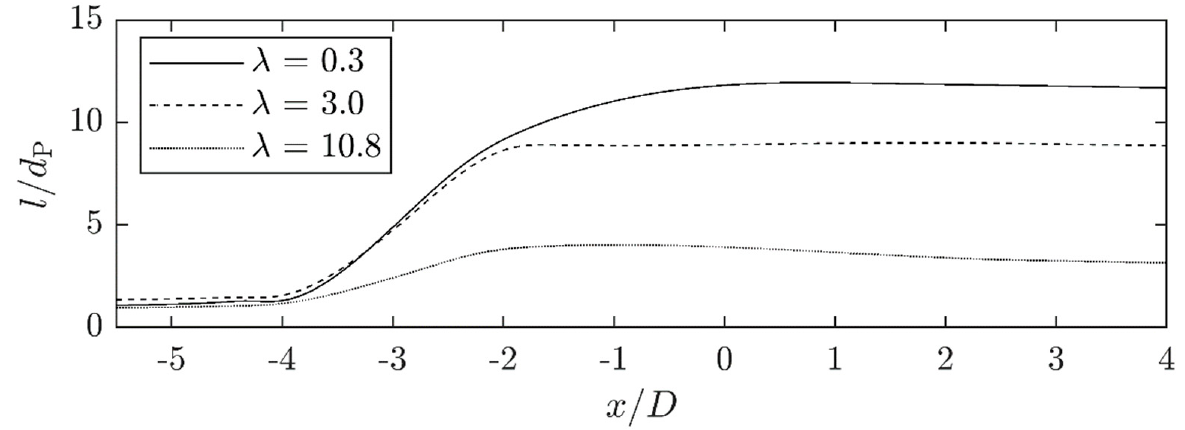
Figure 12. Comparison of the aspect ratio of three drops with different viscosity ratios while traveling through the orifice at a Reynolds number of Re = 2000.